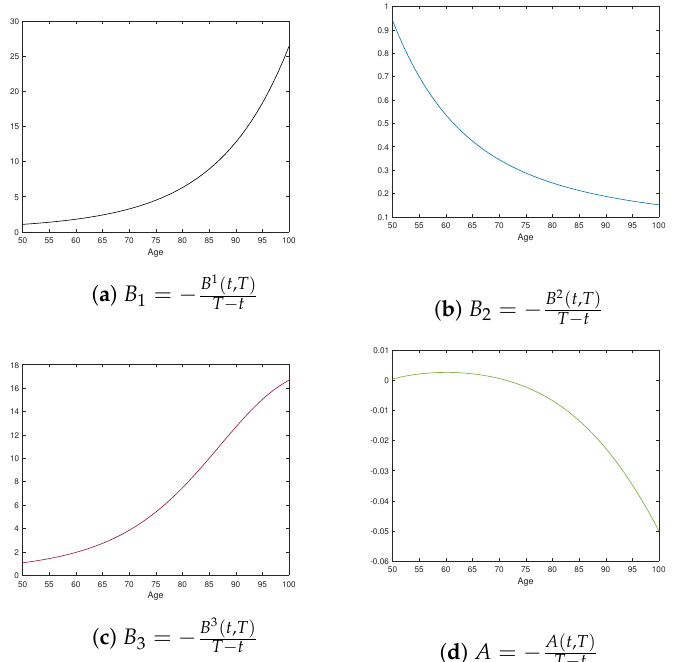
Figure 6. Factors Loadings in the CIR